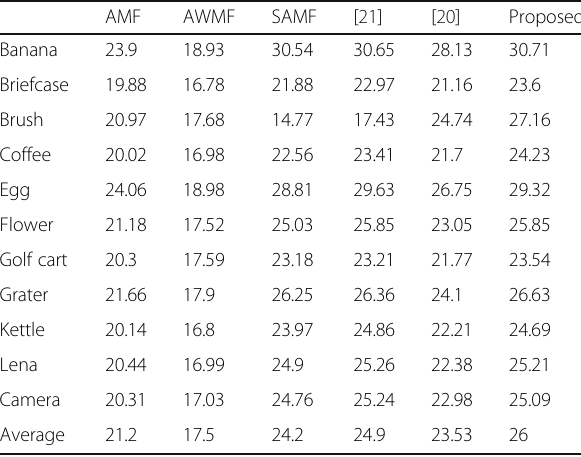
Table 6 PSNR comparison for 90% noise (dB)